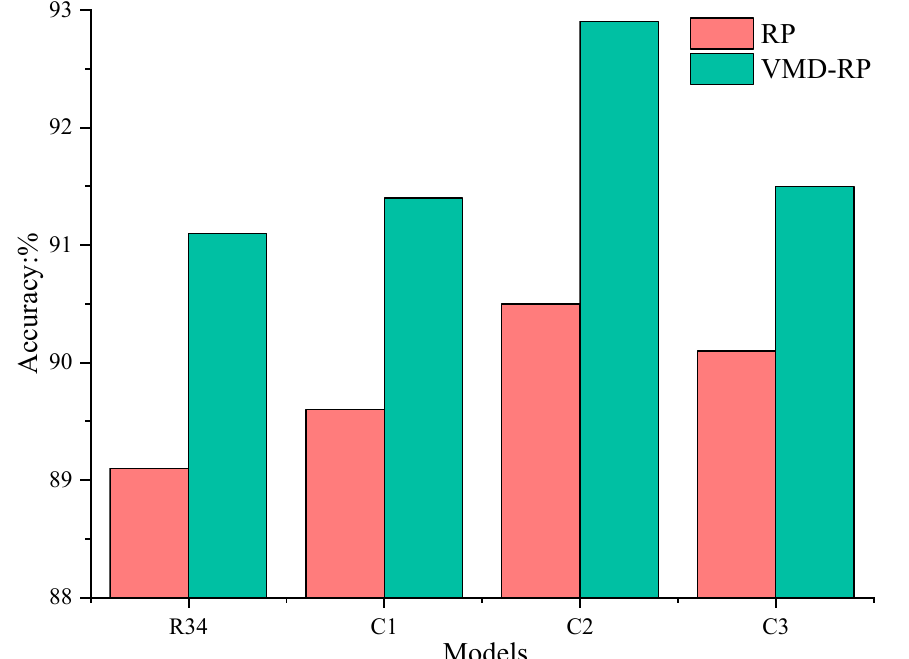
Figure 8. Experimental results of model parameter selection.